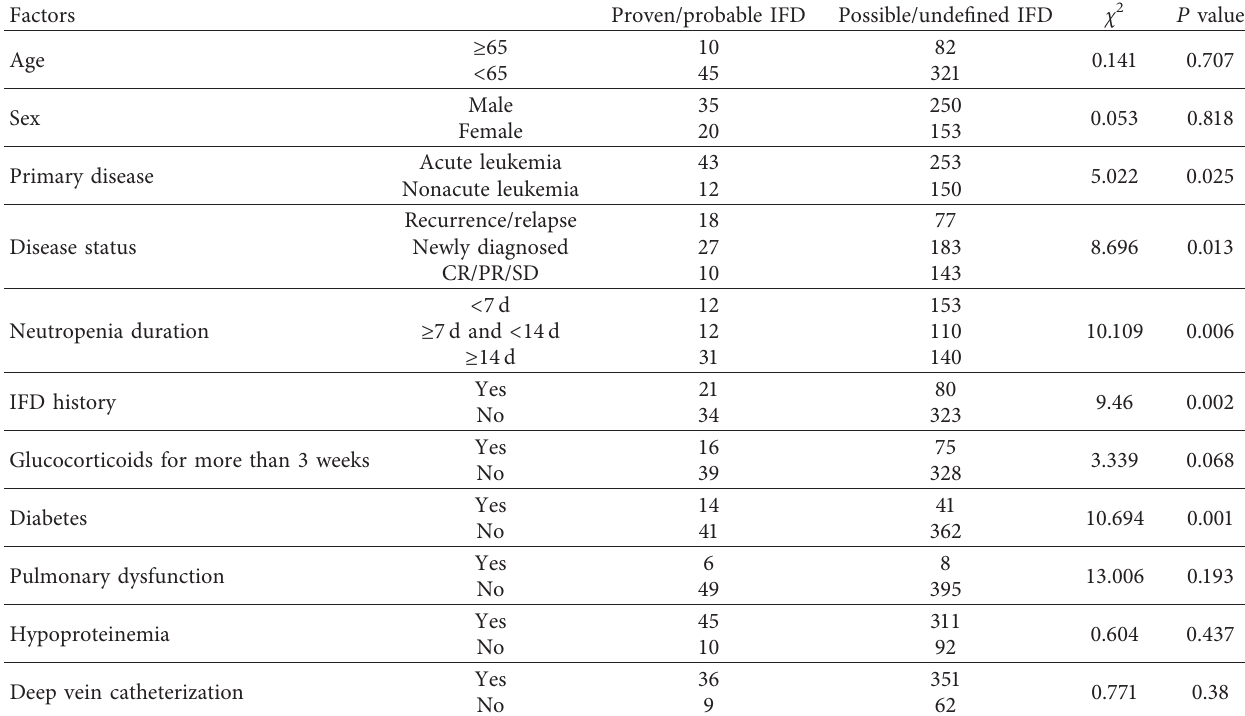
Table 6: Risk factors for IFD based on univariate